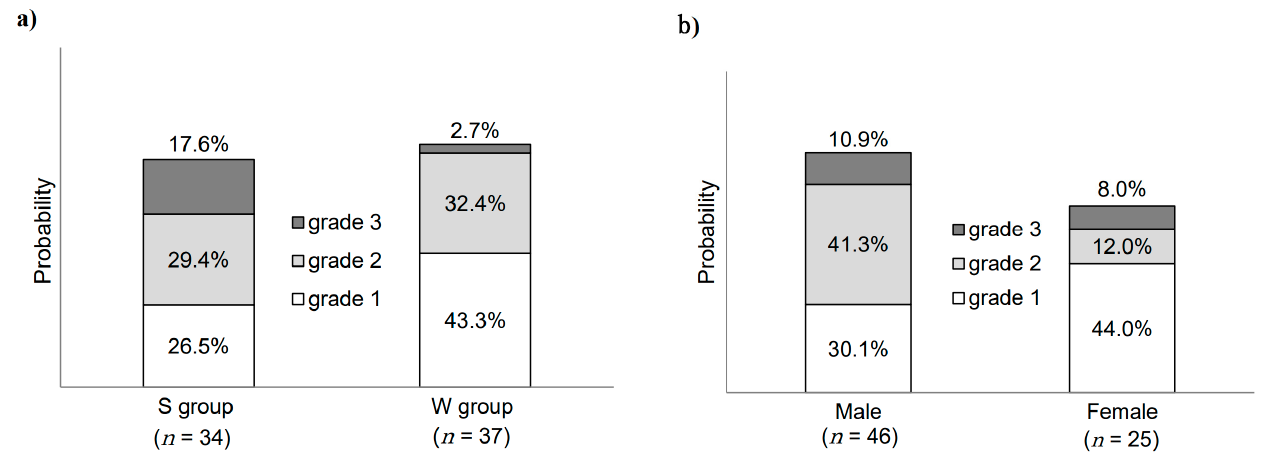
Figure 3. Incidence of acne-like rashes in patients with cancer treated with either cetuximab or panitumumab. ( a ) Incidence of acne-like rashes during the summer (S) and winter (W). ( b ) Incidence of acne-like rashes in males and females.